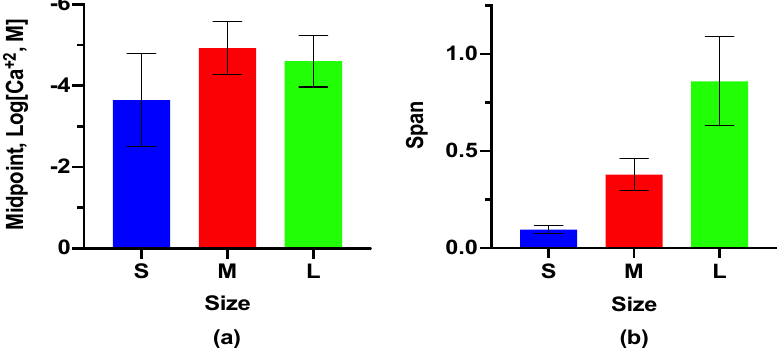
Figure 2. LipiSensors have a clear response to Ca + 2 (fit from eight measurement points, Figure S2): ( a ) the response midpoint is slightly di ff erent ( p = 0.044) across the three varying sizes; ( b ) the response span (max-min signal) of the LipiSensor varies drastically between the three di ff erent sizes ( p < 0.0001). Error bars depict the 95% CI of the non-linear regression from data in Figure S2.